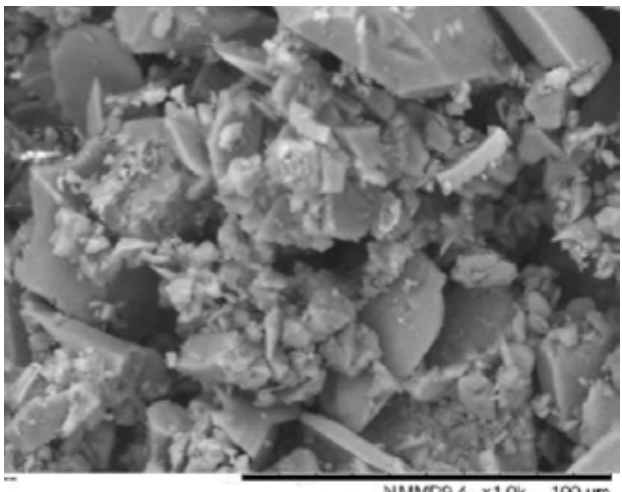
Figure 1. SEM image of cockle shell powder.